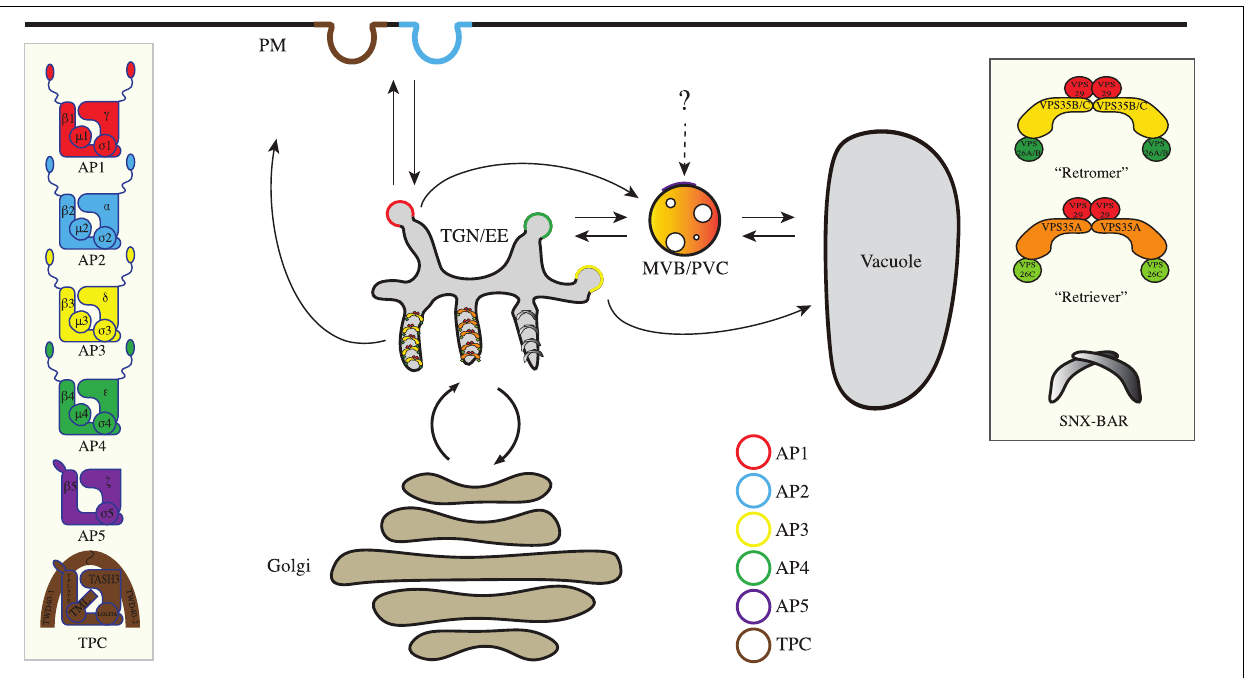
FIGURE 1 | An overview of the coat protein complexes in plant post-Golgi trafficking. Core subunits for the coated vesicle machineries, including AP complexes (AP1-5), TPC, “retromer,” “retriever,” and SNX-BAR complexes in post-Golgi anterograde and retrograde transports are illustrated in boxes. AP, adaptor protein; MVB/PVC, multivesicular body/prevacuolar compartment; PM, plasma membrane; SNX, sorting nexin; TGN/EE, trans-Golgi network/early endosome; TPC, TPLATE complex; VPS, vacuolar protein